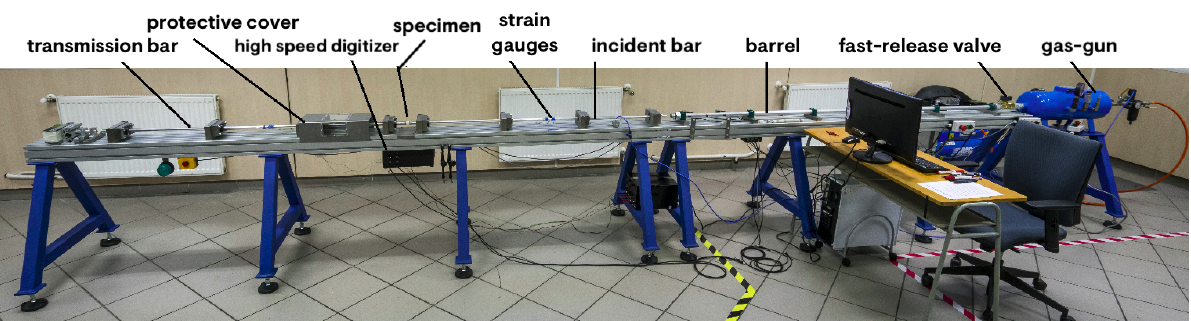
Figure 2. SHPB setup.